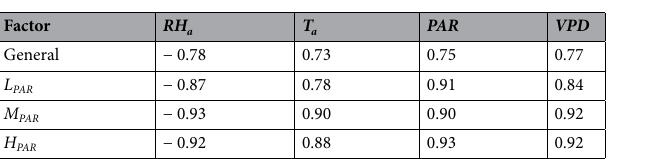
Table 3. Pearson correlation coefficients between V s in cacao plants and microclimatic variables during the monitoring period under different radiation intensities. Types of AFs are described in the methods section and in Fig. 2 . The microclimatic variables are: air relative humidity ( RH a ); air temperature ( T a ); photosynthetically active radiation ( PAR ); and vapor pressure deficit ( VPD ). All correlation coefficients were highly significant ( p <